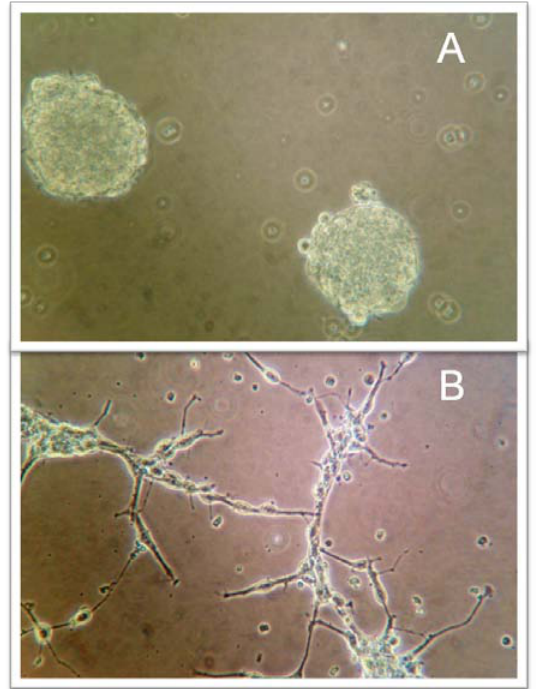
Figure 1. ( A ) Glioblastoma multiforme cells grown as neurospheres in serum-free medium supplemented with epidermal growth factor and basic fibroblast growth factor. ( B ) Cells grown in DMEM with fetal bovine serum and